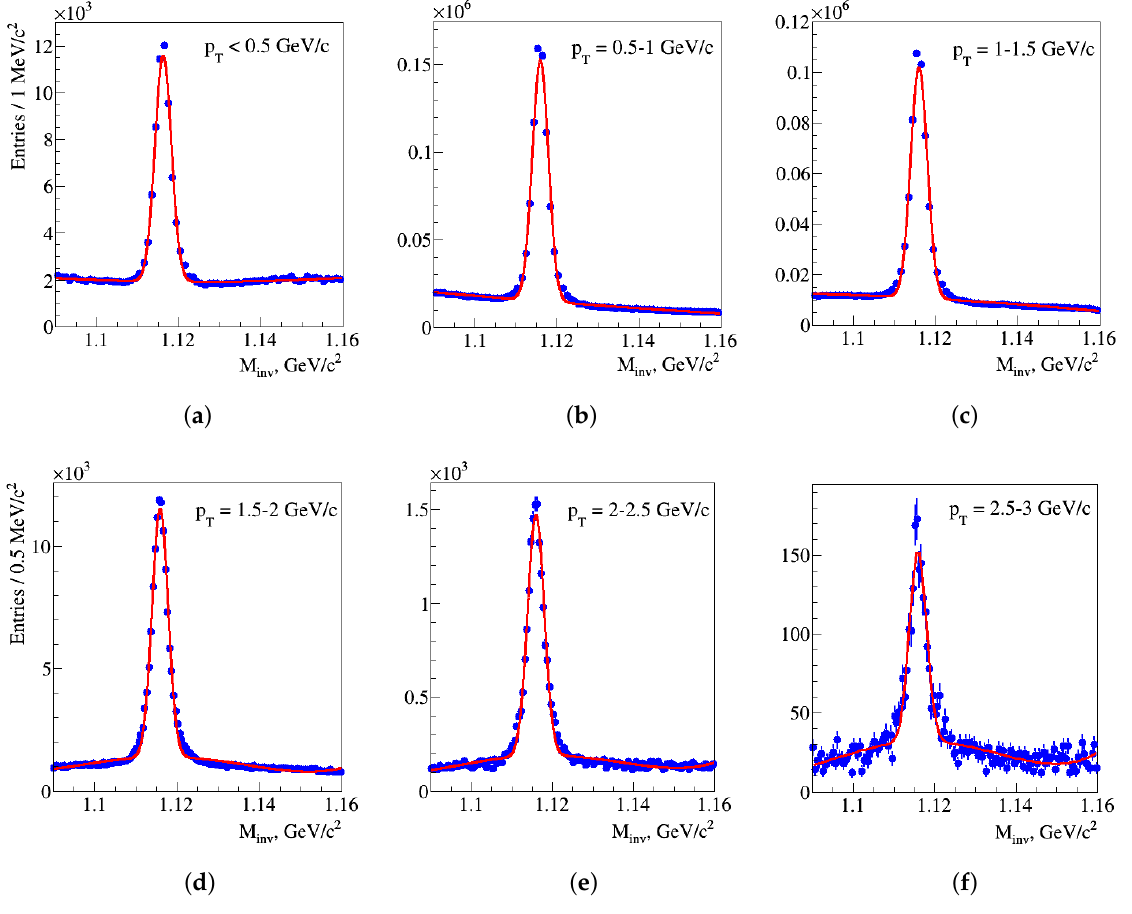
Figure 5. Reconstructed invariant mass of Λ decay products in different p T -intervals: ( a ) p T < 0.5 GeV/ c , ( b ) p T = 0.5–1.0 GeV/ c , ( c ) p T = 1.0–1.5 GeV/ c , ( d ) p T = 1.5–2.0 GeV/ c , ( e ) p T = 2.0–2.5 GeV/ c , ( f ) p T = 2.5–3.0 GeV/ c